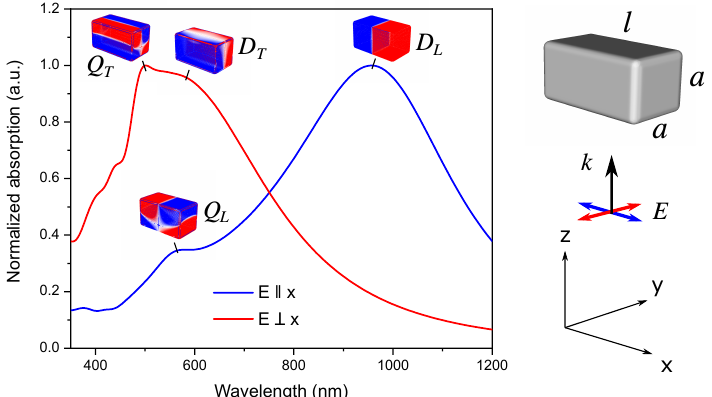
Figure 1. Normalized extinction of Ag nanobar with l = 180 nm and a = 100 nm upon illumination with light polarized parallel (blue) and perpendicular (red) to the long axis of the particle. The charge distribution plots show the corresponding LSPR modes at particular wavelengths: D and Q stand for the dipole and quadrupole modes; indices L and T denote the longitudinal and trans- verse polarization; also shown are the dimensions of the particle, the light propagation direction, and